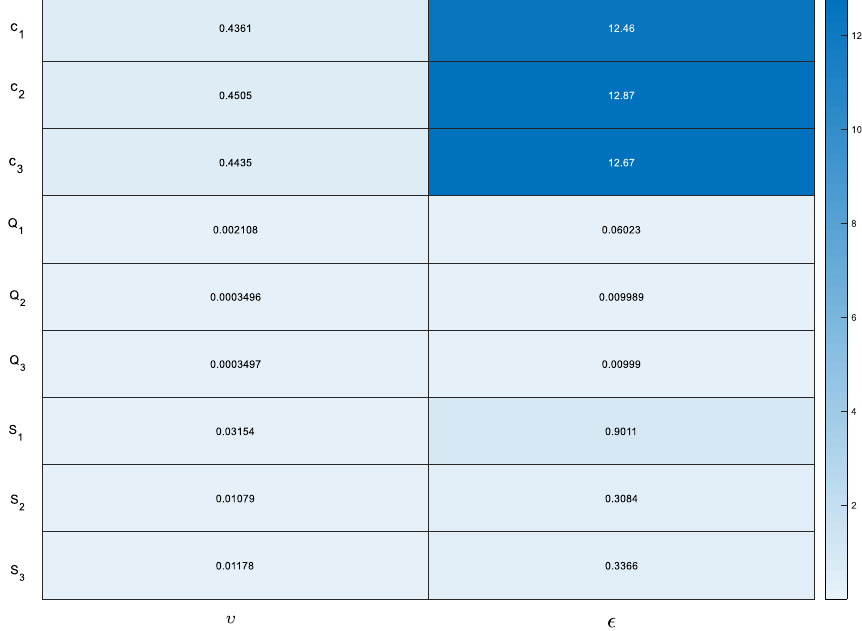
Figure 3. Ranking of involved model parameters on output.